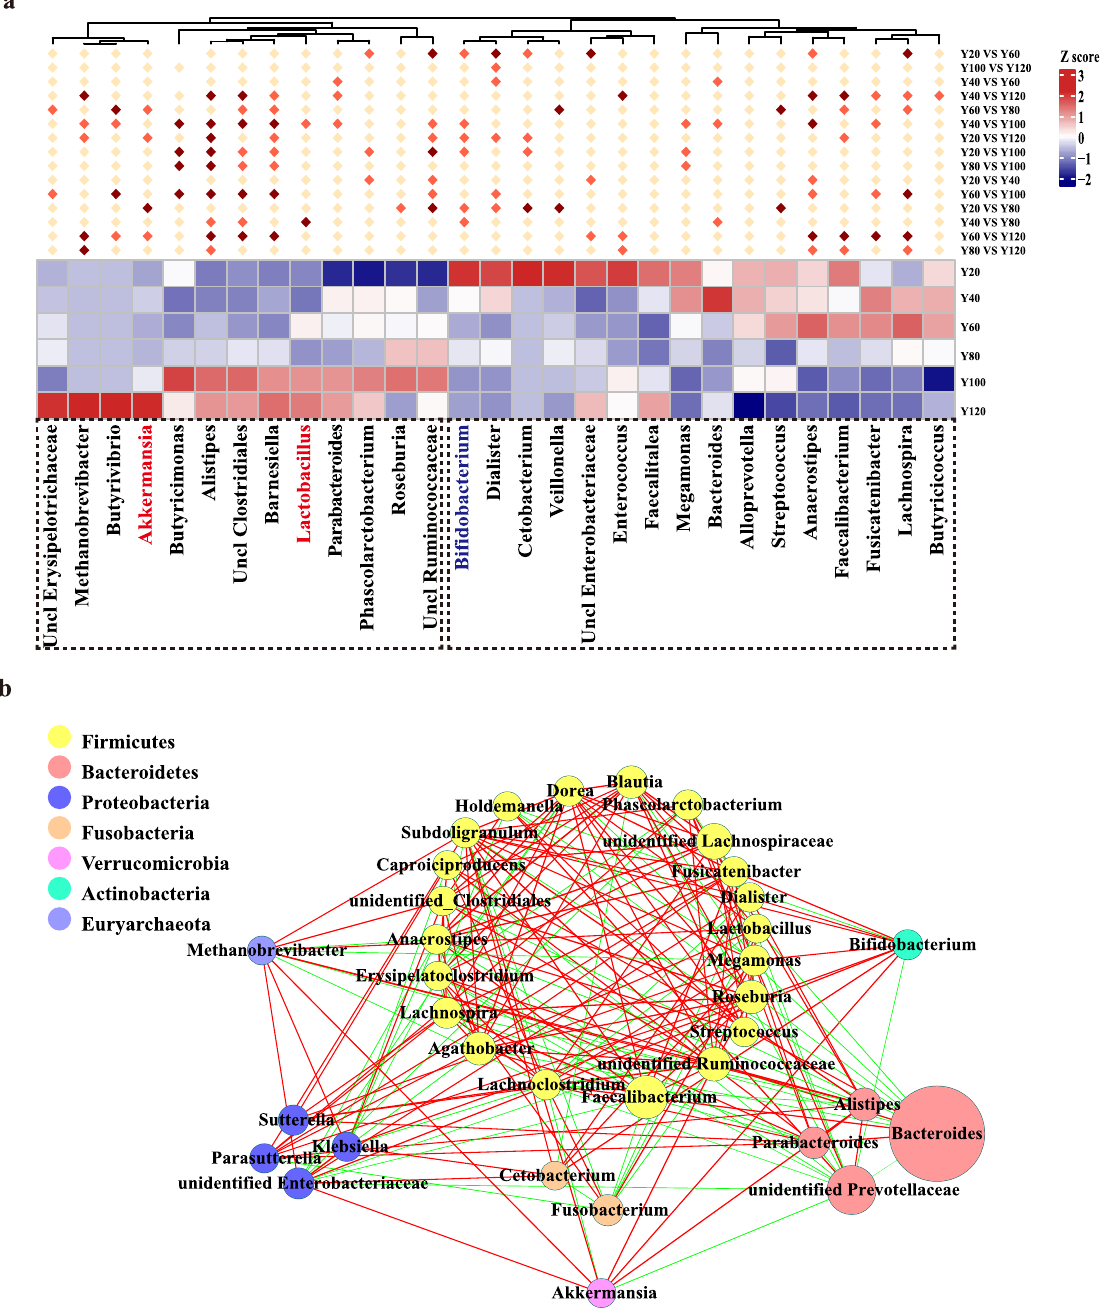
Fig. 2 Age-related gut microbial characteristics. a Relative abundances of age-related gut microbiota Lactobacillus , Akkermansia , Methanobrevibacter , Alistipes , Parabacteroides , Uncl Erysipelotrichaceae , Butyrivibrio , Butyricimonas , Barnesiella , Phascolarctobacterium , Roseburia , Uncl Clostridiales , and Uncl Ruminococcaceae between younger (Y20, Y40, Y60) and older (Y80, Y100, Y120) groups by Wilcoxon rank-sum test, * indicates p < 0.05; ** indicates p < 0.01; *** indicates p < 0.001. b Co-occurrence network analysis of gut microbiota at the genus level. Different nodes represent different genera, the size of the node represents the average relative abundance of the genus, the nodes of the same phylum have the same color, and the thickness of the line between nodes is positively correlated with the absolute value of the correlation coef fi cient of species interaction. The positive and negative correspondence between the color of the connection and the correlation (red positive correlation, blue negative